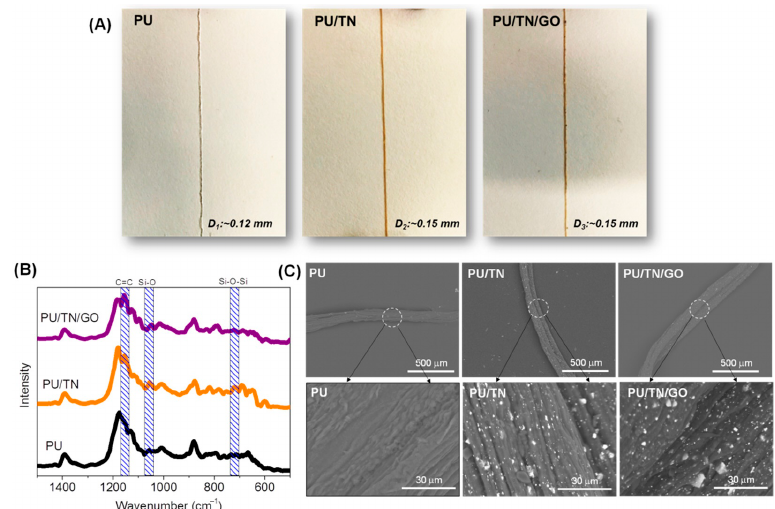
Figure 3. Structure and morphologies of the PU and its nanocomposite fibers: ( A ) images; D 1 : diameter of PU fiber; D 2 : diameter of PU/TN fiber and D 3 : diameter of PU/TN/GO fiber; ( B ) magnified FTIR spectra and ( C ) SEM images; white line area and arrows: magnified area.